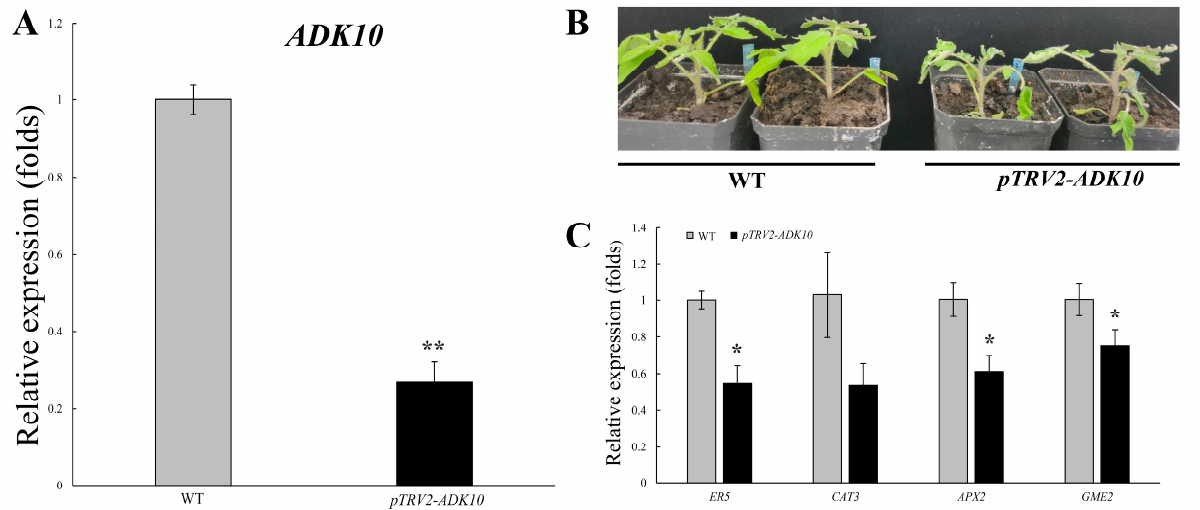
Figure 10. Suppression of SlADK10 leads to drought sensitivity in tomato. ( A ) Detection of SlADK gene expression after virus-induced gene silencing (VIGS). ( B ) Phenotype of TRV2- ADK10 and wild-type plants under PEG6000 treatment for 24 h. pTRV2 - ADK10 showed more obvious wilting symptoms under simulated drought conditions. ( C ) The qRT-PCR analysis of the plant stress-related genes ( ER5 , CAT3 , APX2 , GME2 ) in ADK10 -silenced and WT plants under PEG6000 treatment for 24 h. From three independent biological replicas, data are represented as mean value ± standard error. “*” indicates significant differences between pTRV2 - ADK10 and WT plants with p < 0.05, as determined by Student’s t -test .